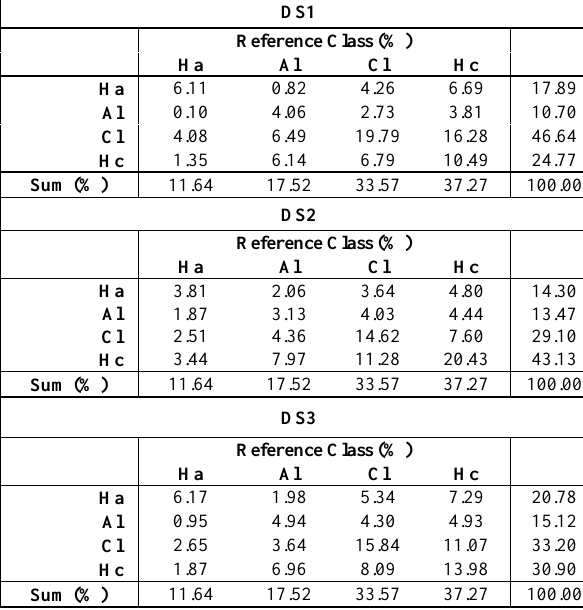
Table 6. Confusion matrix for the data sets classified with